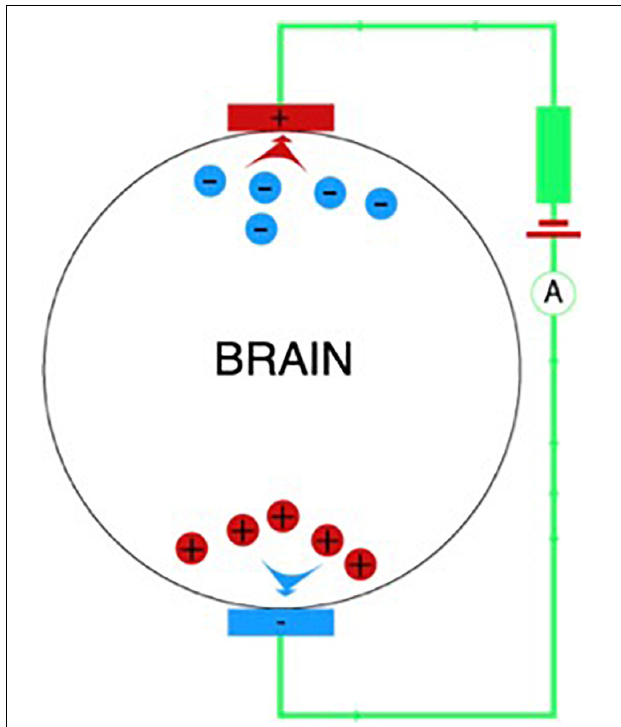
FIGURE 3 | In-phase and antiphase tACS for modulation of the middle frontal theta